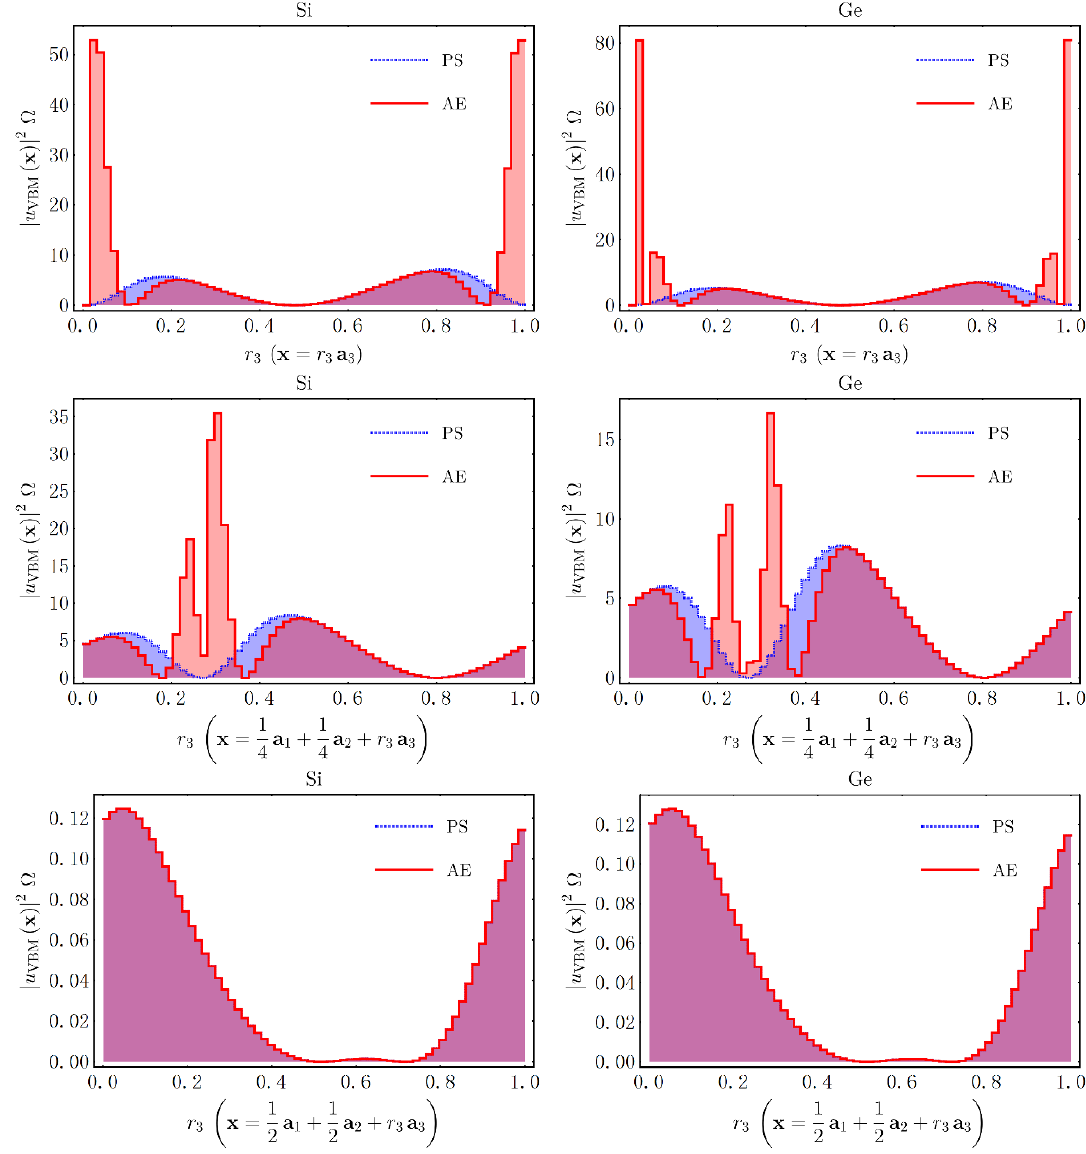
Figure 4 . Comparison of the valence electron densities of the highest valence band state at Γ, for silicon ( left ) and germanium ( right ), determined from the AE ( red ) and PS ( blue ) approaches within the PAW framework, respectively. In the upper row, the densities are along the path x = r 3 a 3 (0 r 3 < 1) inside the UC, while in middle and the bottom rows presented are those along ≤ a 1 + 1 a 2 + r 3 a 3 and x = 1 a 1 + 1 a 2 + r 3 a 3 , respectively. See text for the paths x = 1 4 4 2 2